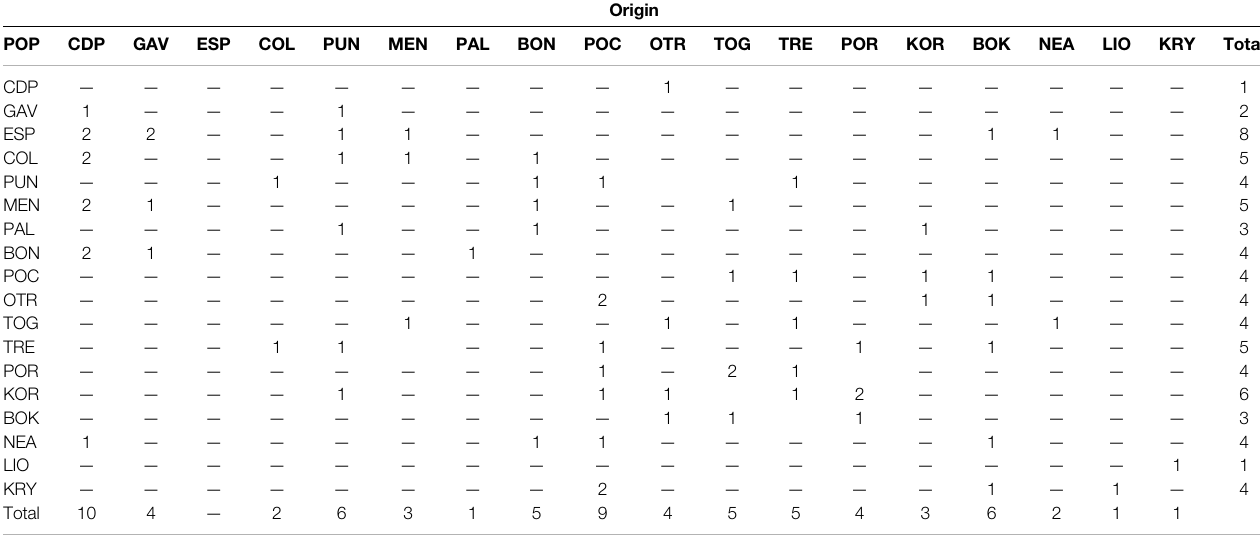
TABLE 6 | First generation migrant test for C. caespitosa. For each population (see acronyms in Table 1 ), individuals are presented according to their sampling site in rows, and in columns, to their origin.